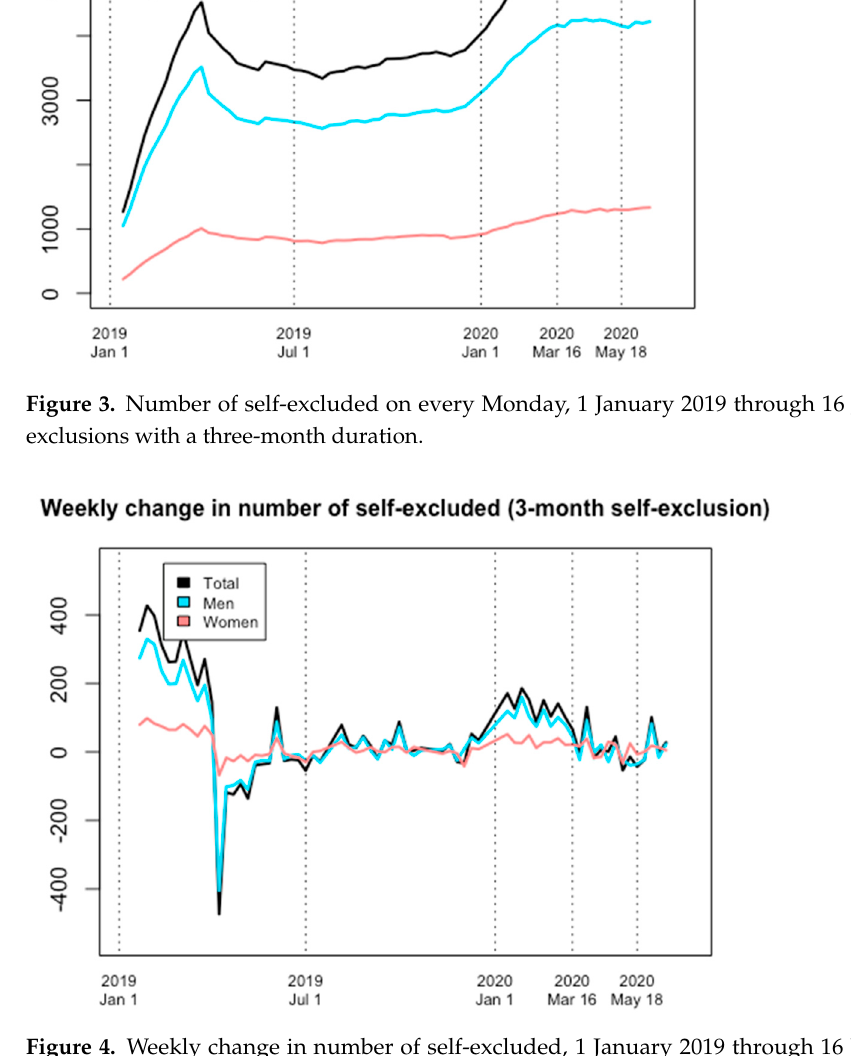
Figure 4. Weekly change in number of self-excluded, 1 January 2019 through 16 June 2020. Self- exclusions with a three-month duration.